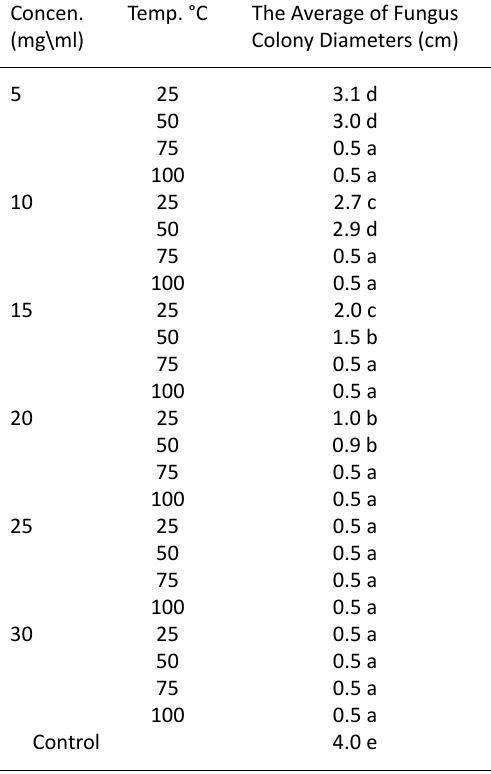
Table 2. The effect of thermal treatments of aqueous chamomile extract on the effectiveness of inhibition growth of Aspergillus fumigatus Concen. Temp.